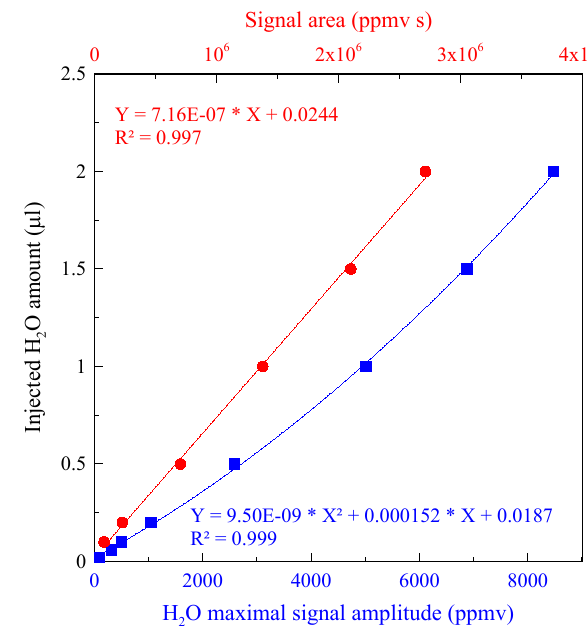
Figure 9. The relationship between the sample signal and the in- jected water amount for the vapour is used to calibrate the released water amount from fluid inclusions. Calibration was determined for amounts up to 2µl using a wet background and based on two schemes: (i) with the signal area converted into water amounts (lin- ear regression in red) and (ii) relative to the maximal signal intensity (polynomial regression in